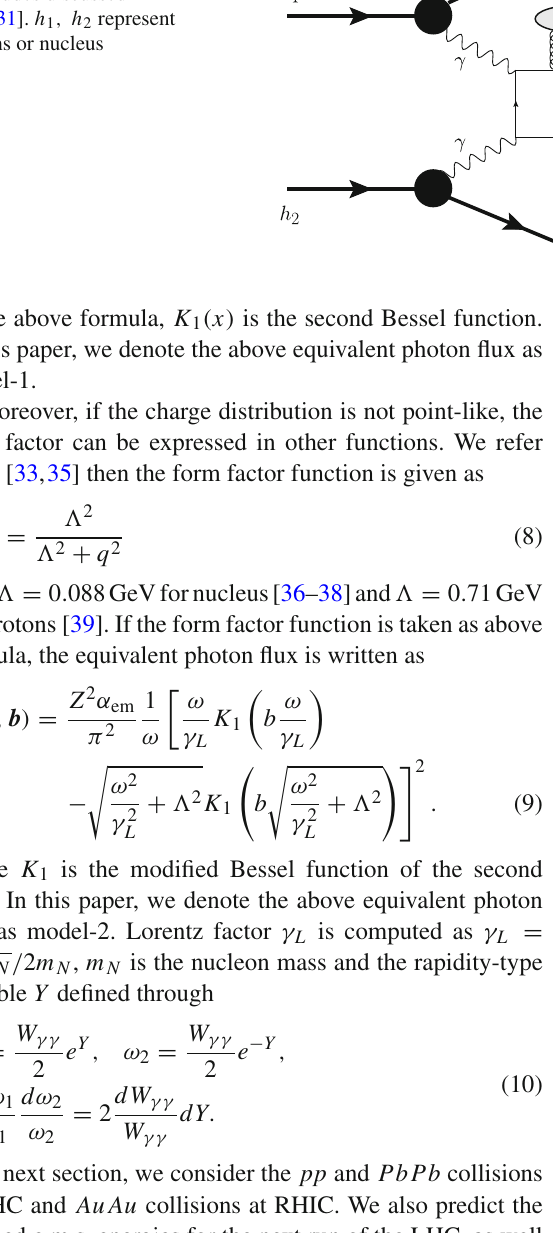
Fig. 1 Two typical diagrams of h 1 h 2 → h 1 h 2 π 0 G 2 . The blobs denote the distribution amplitudes discussed in Ref. [31]. h 1 , h 2 represent protons or